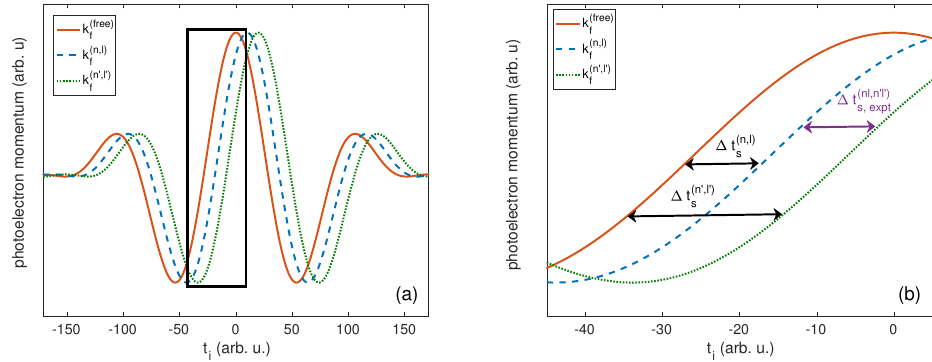
Figure 1. Conceptual visualization of the different streaking time delays in photoionization, namely the ( nl , n (cid:48) l (cid:48) ) experimentally observed delay ∆ t between streaking traces for emission from initial states | n , l > s , expt ( nl ) ∆ t ( n (cid:48) l (cid:48) ) and | n (cid:48) , l (cid:48) > and the theoretically considered delays ∆ t s and s with respect to the streaking trace of a free electron. Panel ( b ) is an enlargement of the full traces shown in panel ( a